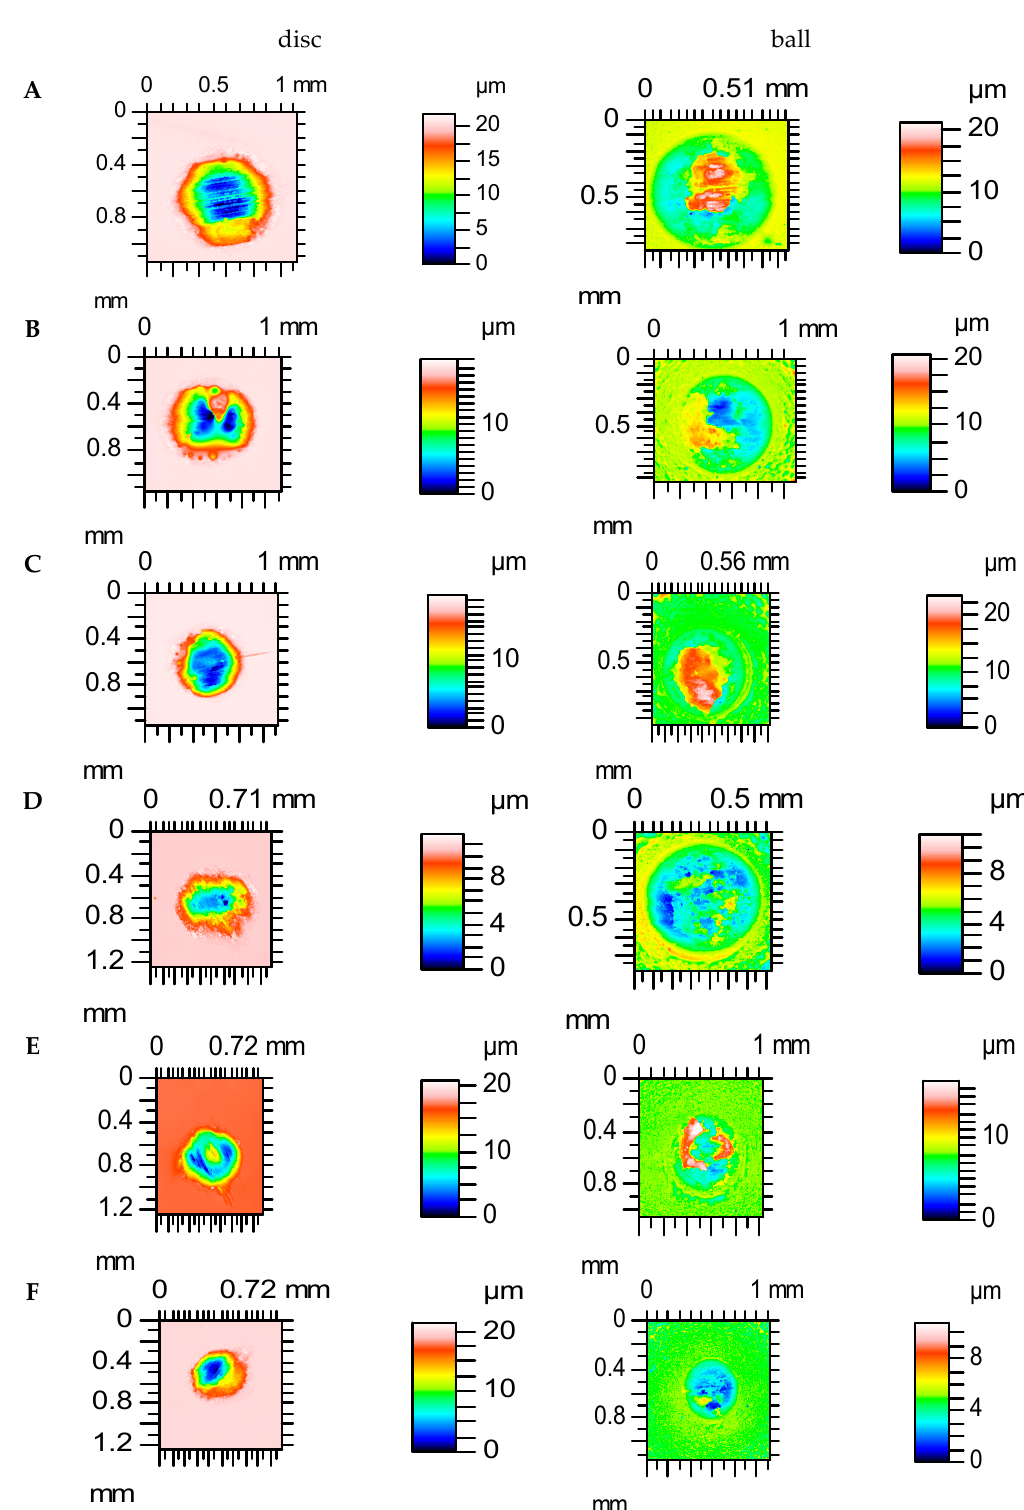
Figure 10. Contour maps of polished disc P and contacted balls after tests: ( A – F ).